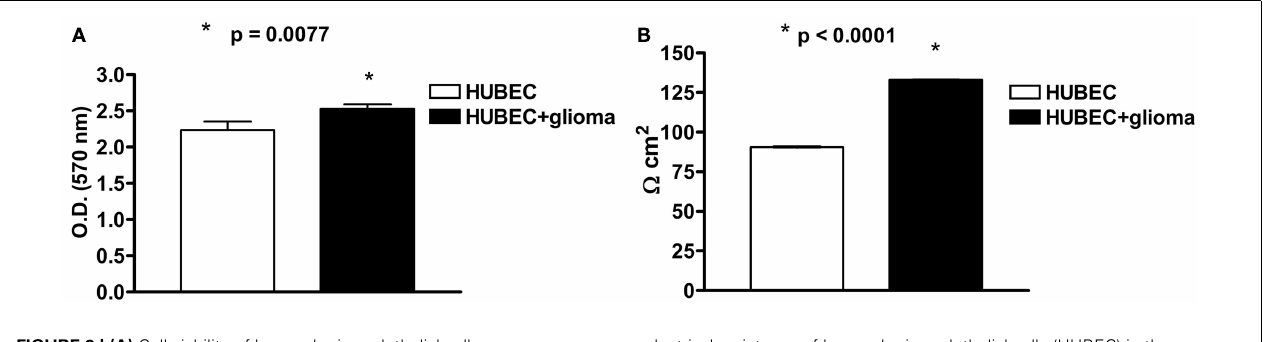
FIGURE 2 | (A) Cell viability of human brain endothelial cells (HUBEC) in the presence or absence of glioma cells.The results are shown as mean ± SEM of optical density (OD) values of duplicate batches of three independent cultures (2 × 10 4 cells/well) from three different tumors listed in Table 1 ( n = 3). (B)